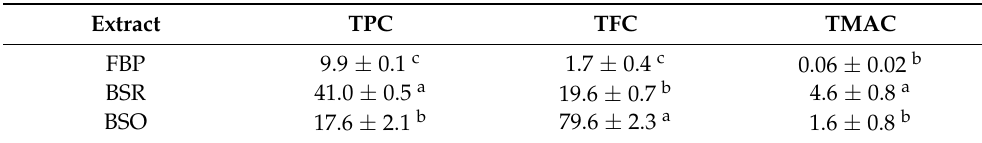
Table 1. Total phenolic content (TPC, mg GAE/g extract), total flavonoid content (TFC, mg QCE/g extract), and total monomeric anthocyanin content (TMAC, mg C3GE/g extract) of pulp and seed extracts of C. album